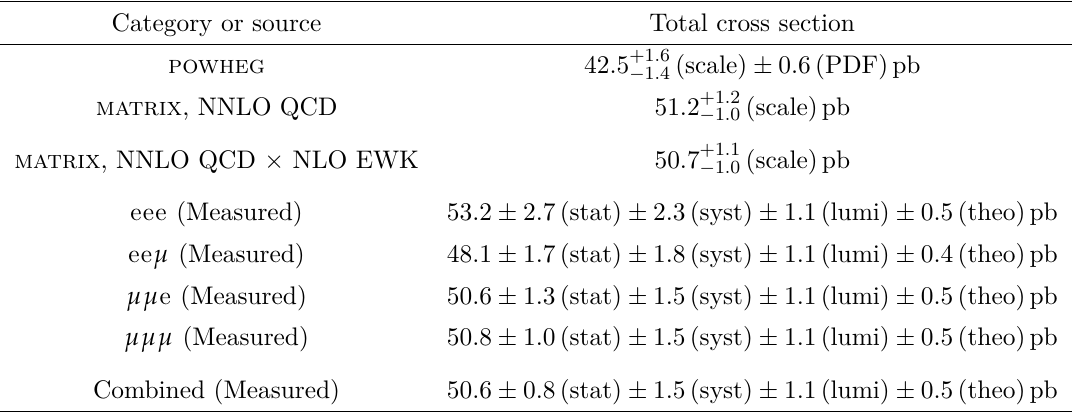
Table 6 . Measured total cross sections and their corresponding uncertainties for the flavour- exclusive and flavour-inclusive categories. The predictions from both powheg at NLO in QCD and LO EWK as well as several ones obtained from matrix (NNLO QCD, NNLO QCD × NLO EWK) are also